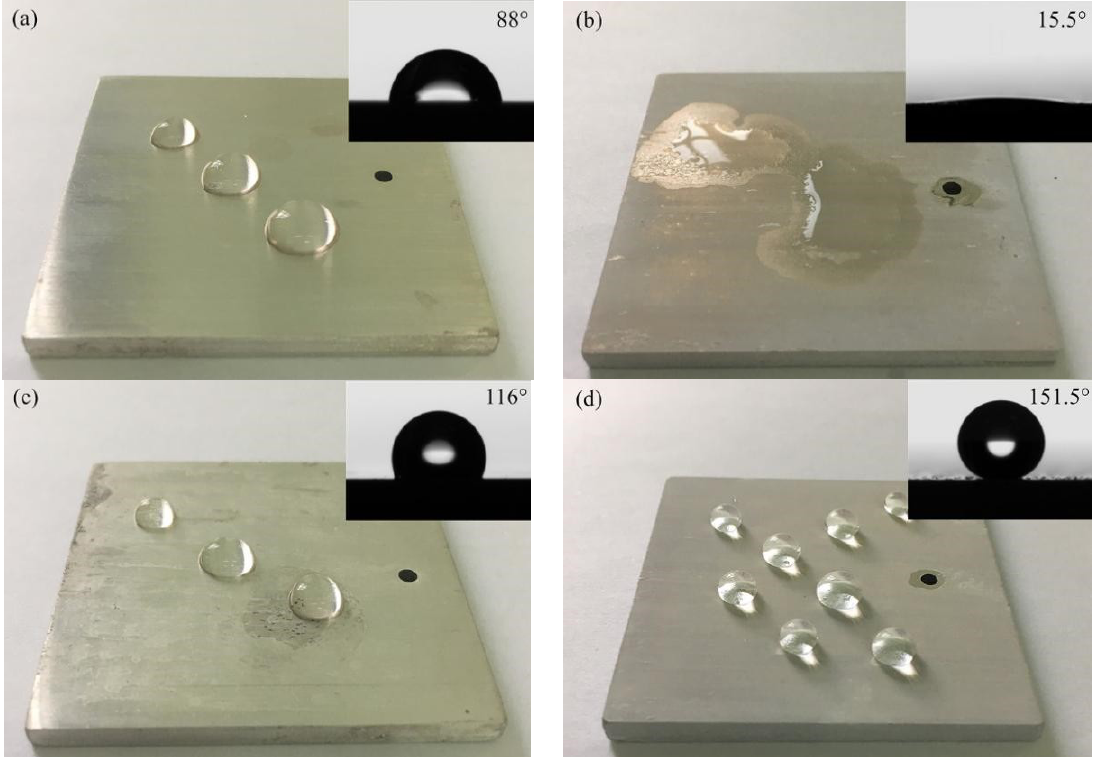
Figure 7. Images of distilled water droplets and the contact angle results (inset) of typical samples: ( a ) Blank: 88°; ( b ) CD: 15.5°; ( c ) Blank+HT: 116°; ( d ) CD+HT: 151.5°.